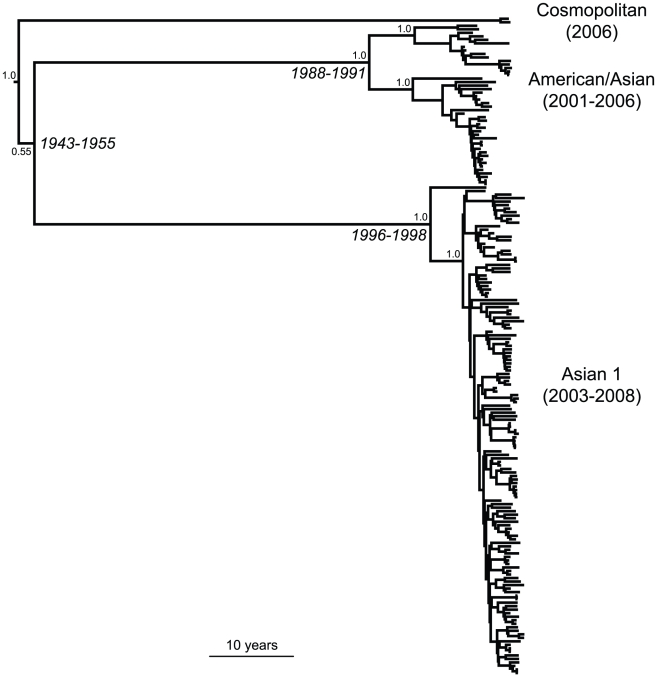
Maximum clade credibility (MCC) tree of complete coding region sequences of DENV-2 sampled in Viet Nam.The major genotypes of DENV-2 and their sampling times (in parentheses) are marked. The 95% credible values for the time to the most recent common ancestor of the Asian I and Asian/American genotypes in Viet Nam are shown. In all cases tip times reflect the day of sampling of each virus. The tree is automatically rooted under the assumption of a molecular clock.